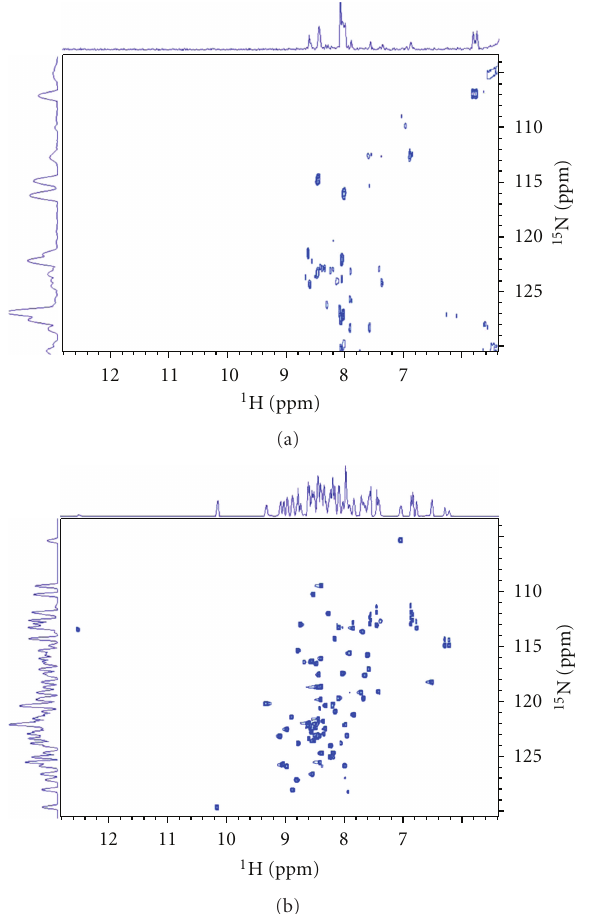
Figure 4: The 1D 1 H-NMR of amide proton resonances (7,5– 10ppm) and 1 H- 15 N HSQC of the mutant (a) and the native RING